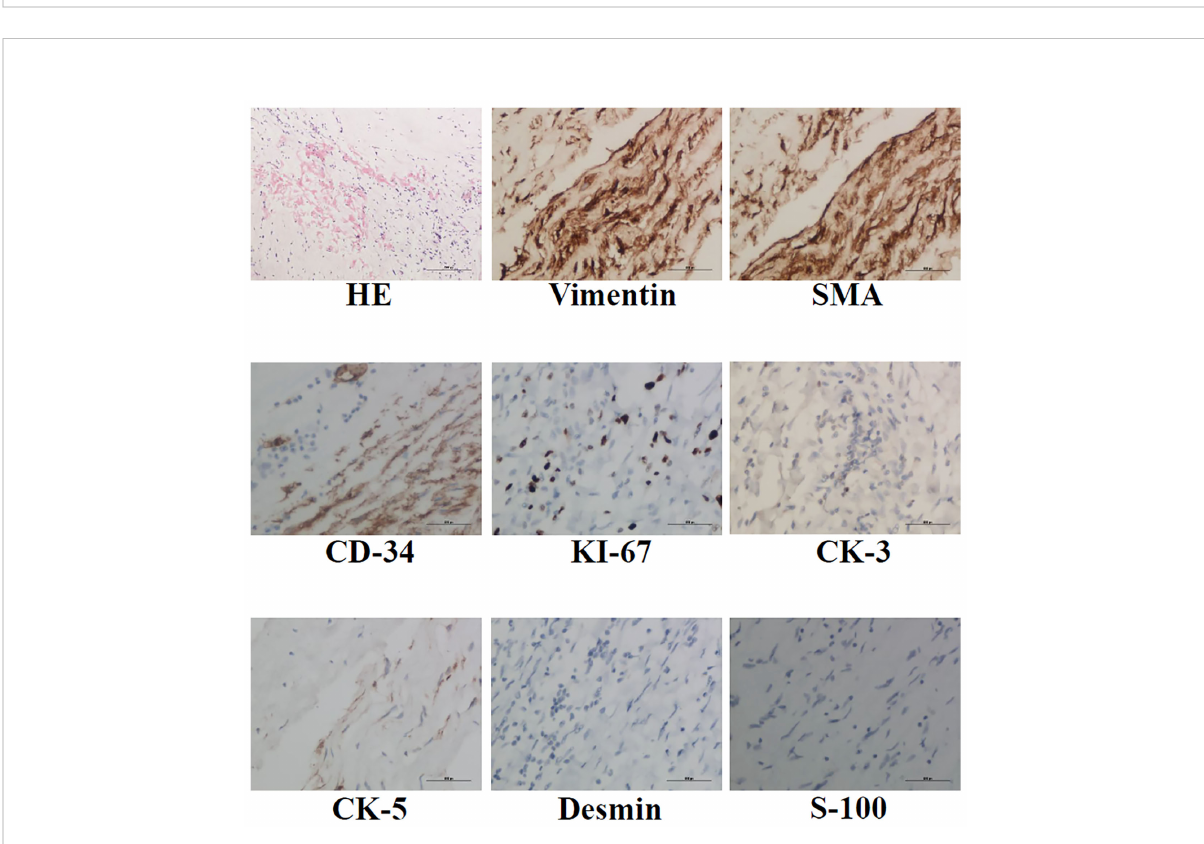
FIGURE 3 HE, anti-vimentin, SMA, CD-34, CK-3, CK-5, desmin and s-100 immunohistochemistry staining was performed to identify